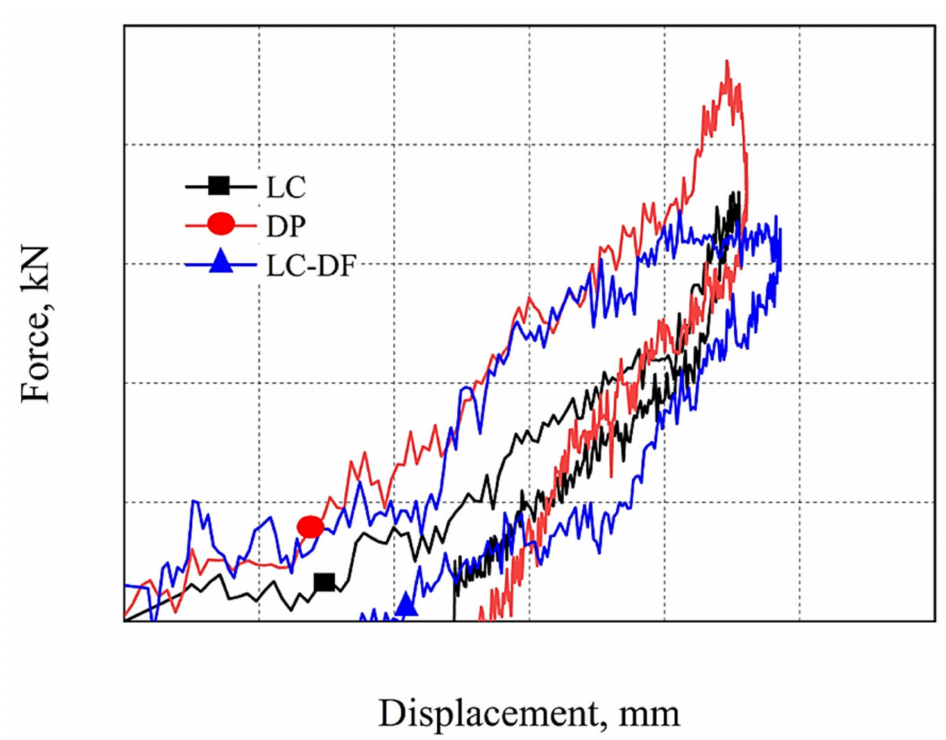
Figure 20. Force–displacement assessment during the impact test on LC, DP, and LC–DP